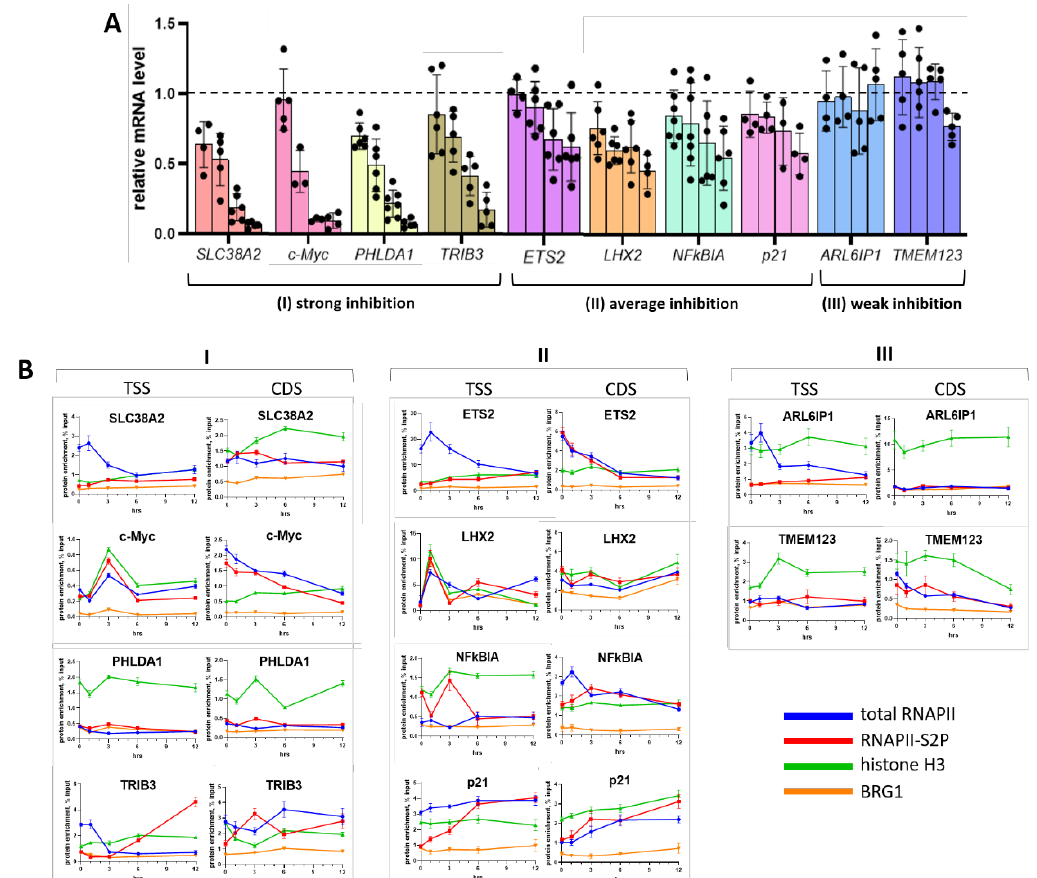
Figure 5. Differential gene sensitivity to the inhibitory effect of OA. ( A ) HCT116 cells were incubated with 100 nM OA for up to 12 h. Relative mRNA levels were determined by qPCR and normalized to RPLP0 mRNA. Signals in untreated cells (0 h) were taken as 1 (dotted line). In each group of four bars (from left to right): 1 h, 3 h, 6 h, and 12 h, respectively. ( B ) Time-dependent changes of total RNAPII, elongating RNAPII-S2P, core histone H3, and BRG1 around TSS or on CDS. Data are mean ± SD of three measurements. Genes were grouped according to their sensitivity to OA: highly sensitive genes (I, left panel), averagely sensitive genes (II, middle panel), and weakly sensitive genes (III, right panel).